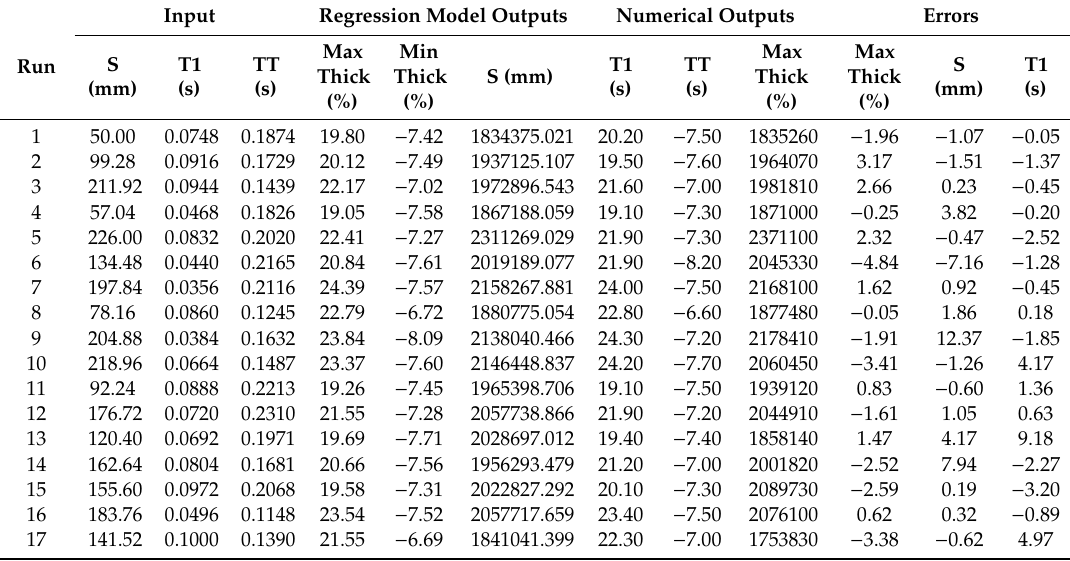
Table 8. Numerical and regression model values correlation for blank1